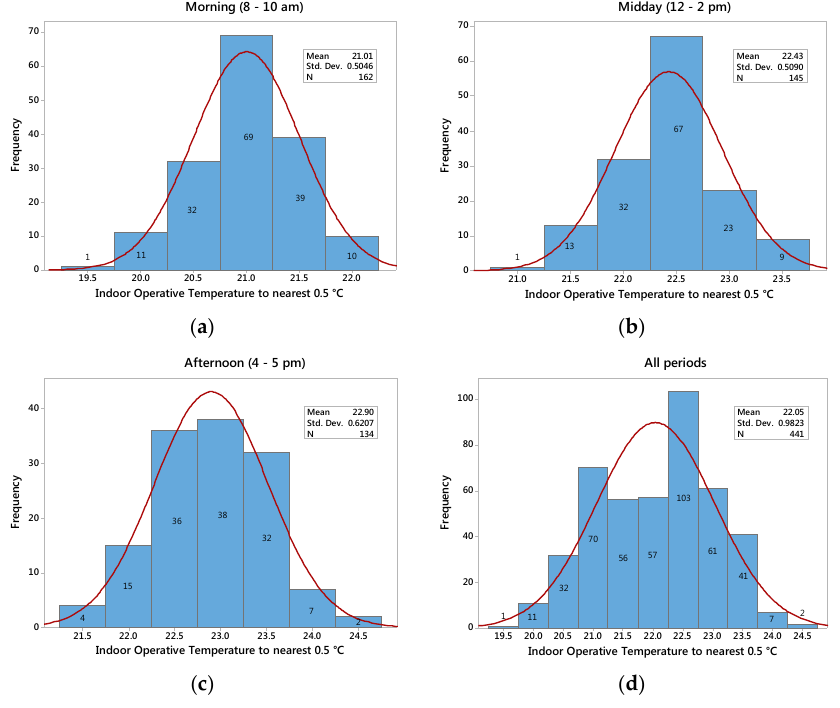
Figure 6. Histograms of indoor operative temperatures in the analyzed office: ( a ) indoor operative temperatures in the morning; ( b ) indoor operative temperatures in the midday; ( c ) indoor operative temperatures in the afternoon; ( d ) indoor operative temperatures during the experimental campaign.